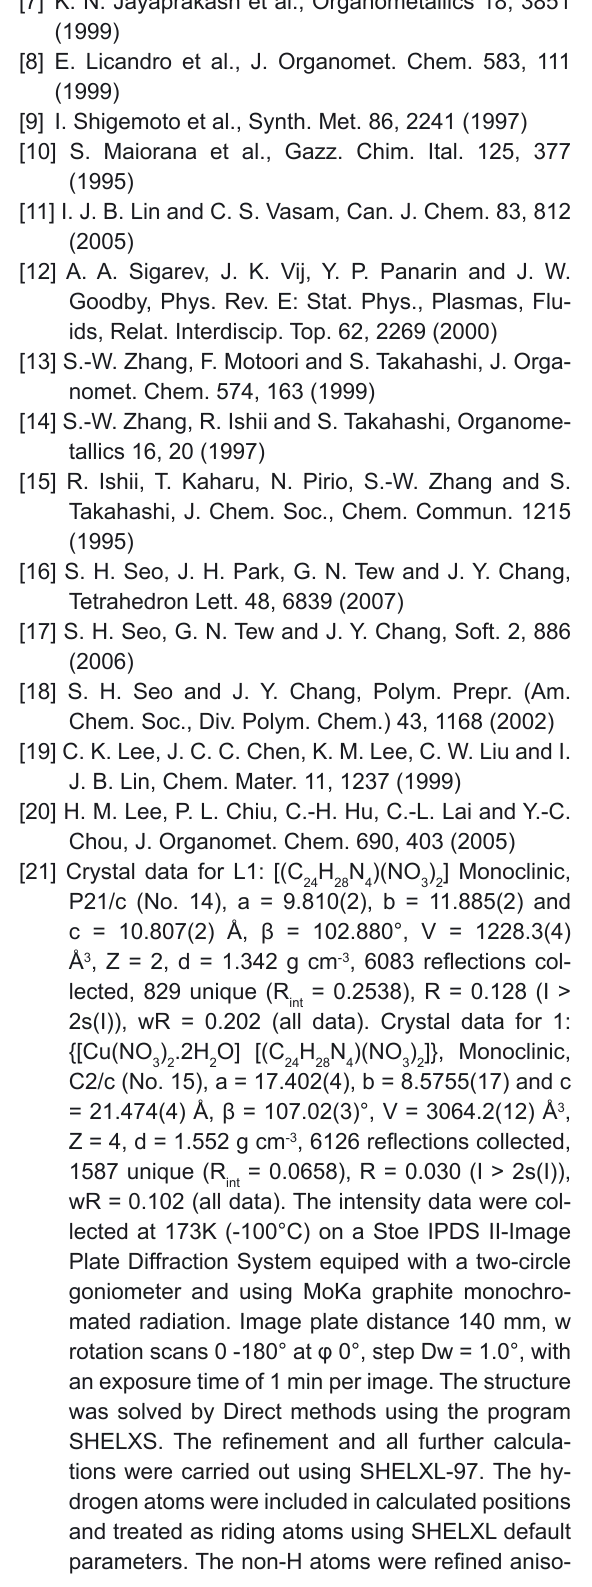
tropically, using weighted full-matrix least-squares on F 2 . The crystallographic analysis was performed using PLATON. For molecular and crystal structure visualization the software DIAMOND was used. CCDC 662522 and 662622 contains the supple - data can be obtained free of charge from The Cam